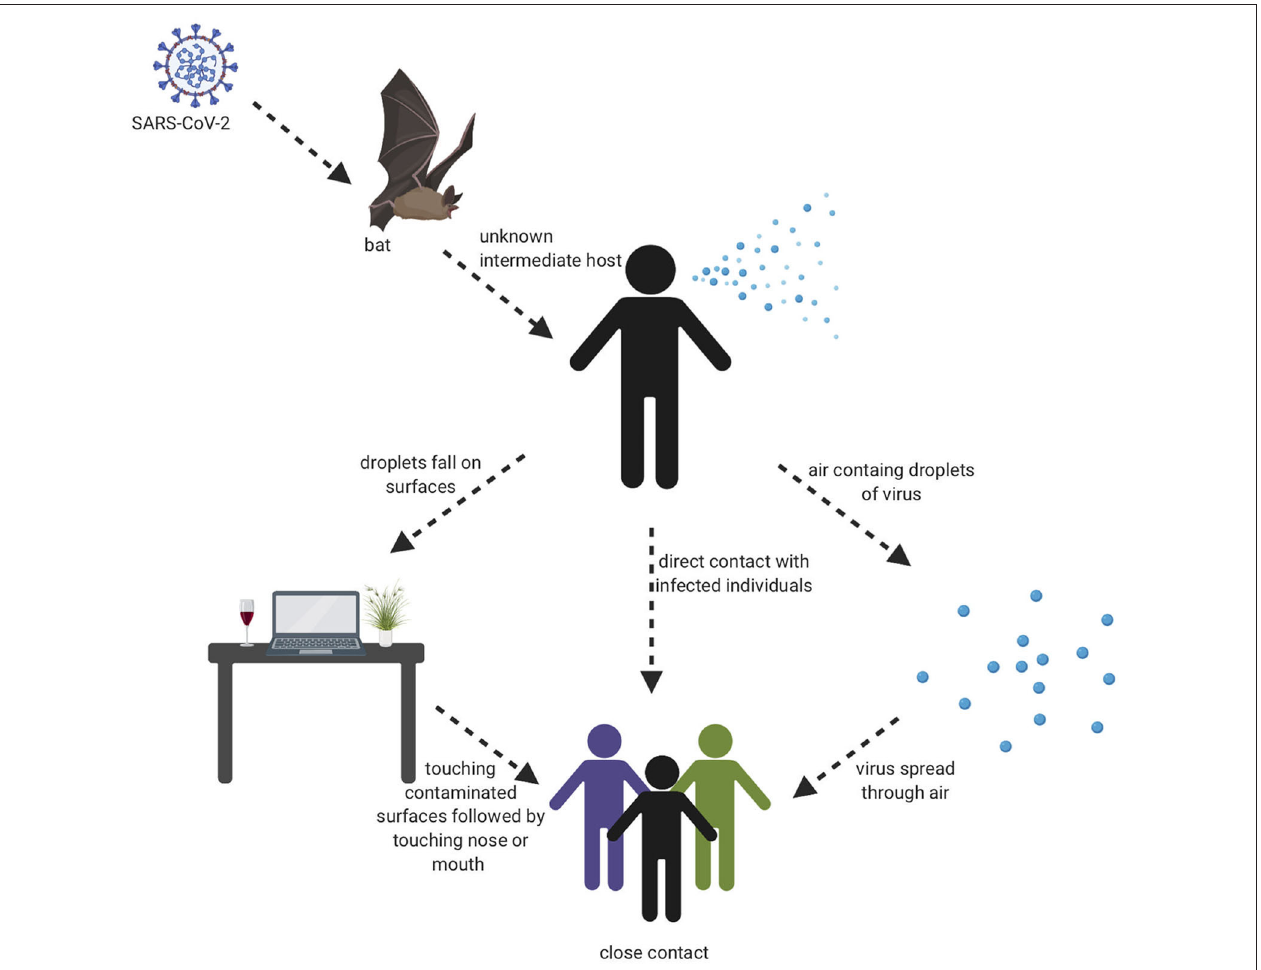
FIGURE 2 | Transmission cycle of SARS-CoV-2. It is believed that animal to human transmission is the main cause of infection through consuming an infected animal as a source of food. Then, the infection can spread through person to person, aerosols, and touching contaminated surfaces.